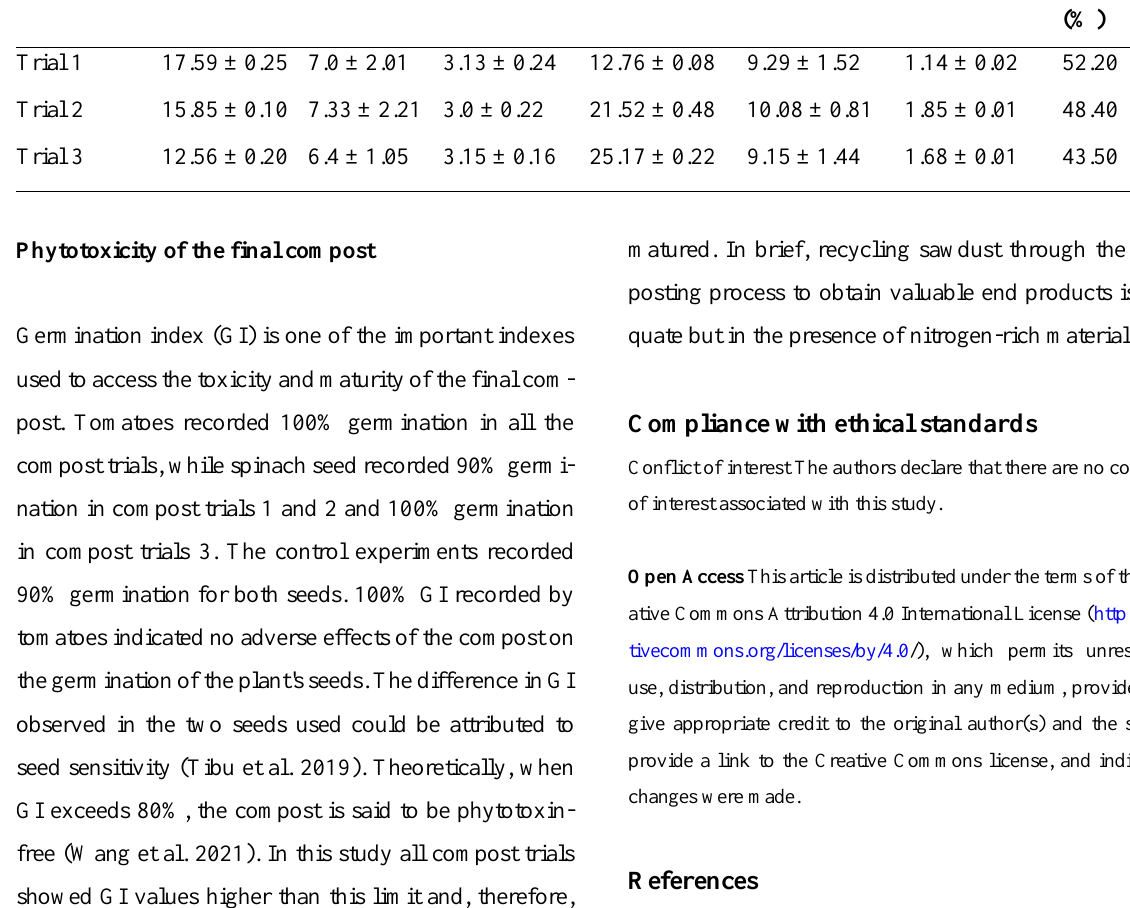
Table 4 Chemical properties of the final compost Composting